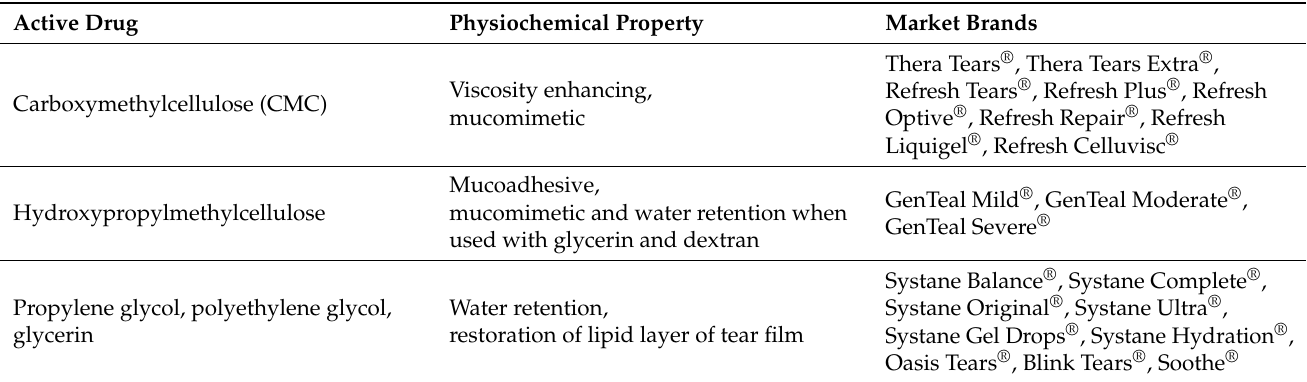
Table 1. List of active ingredients in artificial